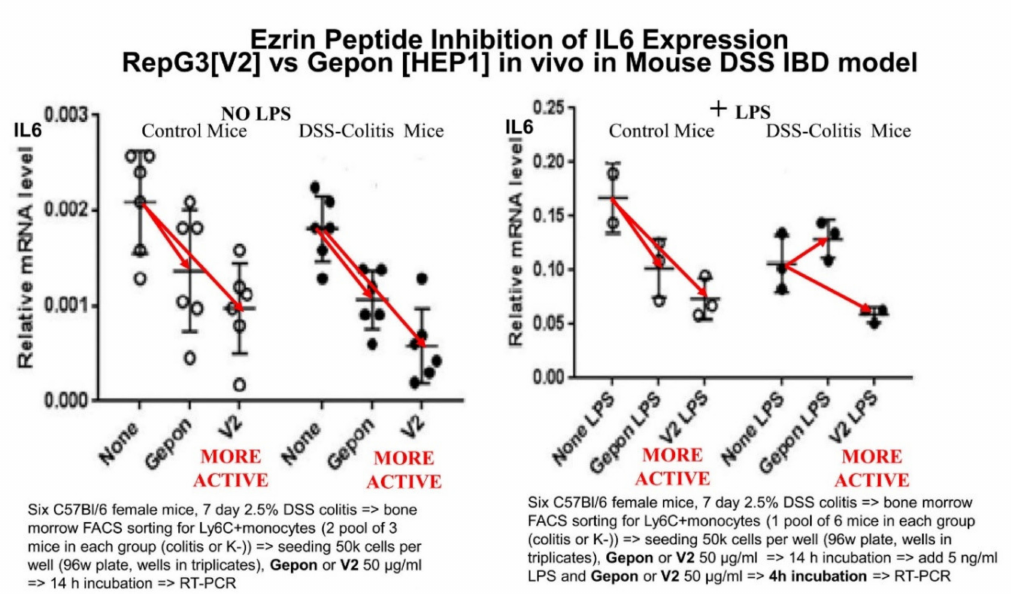
Figure 6. Ezrin peptides HEP1 TEKKRRETVEREKE (Gepon) and RepG3 GEKKRRETVEREGG (V2) have anti-inflammatory effects in vivo that correlated to reductions in IL-6 mRNA expression in both control mice (no DSS) and DSS-colitisinduced mice, in the presence and absence of LPS. The length of the red arrows draw attention to the relative amount of inhibition of IL-6 expression (LPS means lipopolysaccharide, a major component of gram-negative bacteria cell-walls that is a potent activator of monocytes/macrophages and causes an acute inflammatory response and release of inflammatory cytokines).